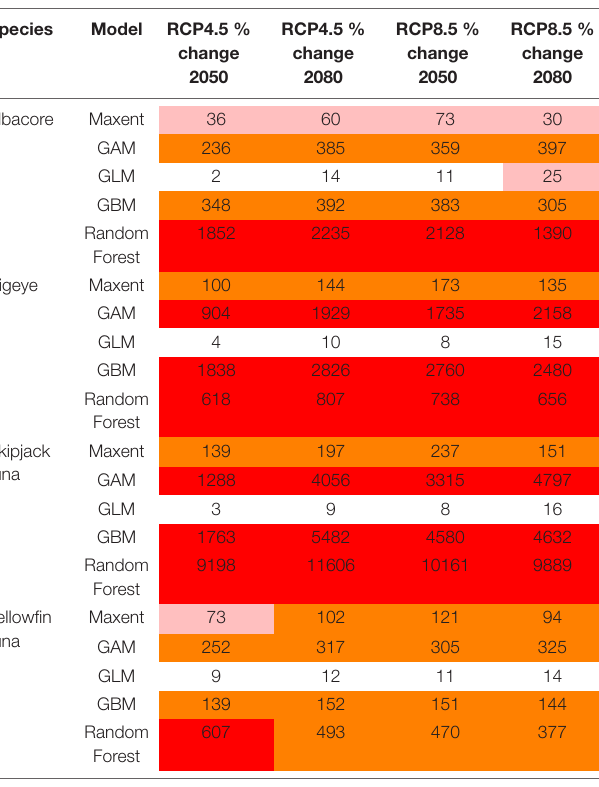
Projected decreases between 25 and 75% are shown in pale blue, decreases greater than 75% are shaded in dark blue. Projected increases between 25 and 75% are shaded in pink, increases greater than 75% in dark brown, and increases greater than 500% in red. Southern bluefin tuna are not included here because